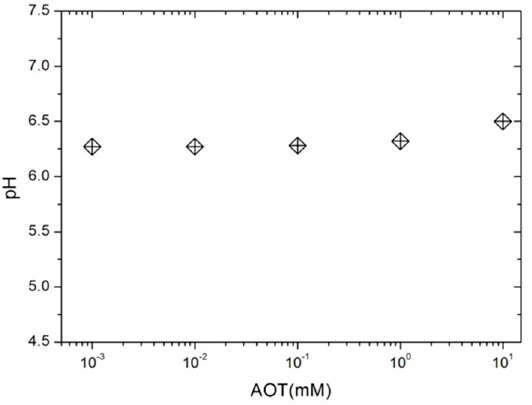
Figure 3. Relationship between pH and AOT concentration in aqueous AOT solution.